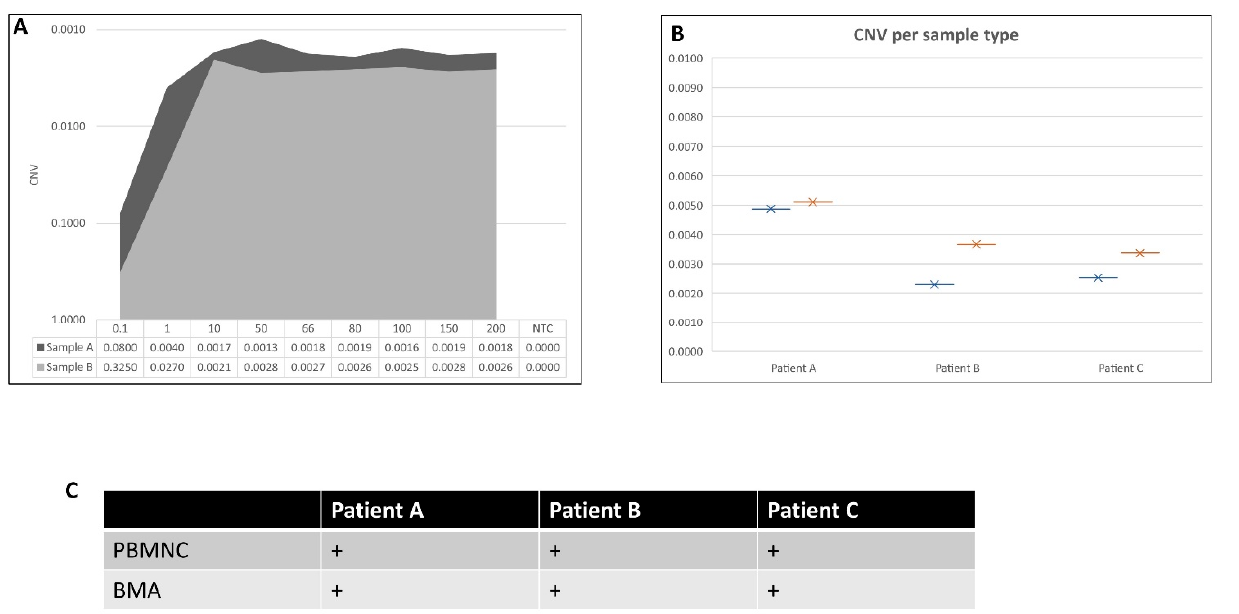
Figure 5. ( A ) Here, two samples, A and B, were used to measure CNV at different concentrations. The area chart demonstrates the CNV, measuring consistency between 10 and 200 ng/ µ L. A sudden drop in CNV levels was observed below 10 ng/ µ L for each patient. LoQs were 0.002 and 0.0007 for Samples A and B, respectively. ( B ) Three samples were run here (A, B, and C), with the starting material from each sample being either PBMNC or isolated CD3+ T cells. A comparison between PBMNC samples (blue) and isolated CD3+ T cells (orange) demonstrated consistency between the two different sample types. ( C ) CNV reporting on three patients, with the starting sample material being either PBMNC or BMA (at the same patient timepoint). The table shows when a CNV was reported as above (+), below ( − ), or equal to (=) the LoQ.